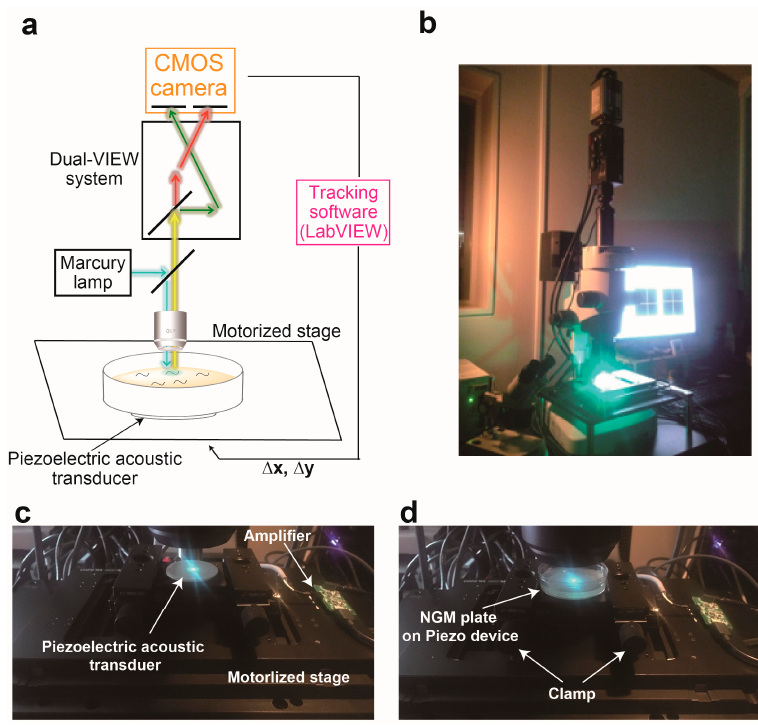
Figure 1. A system integrating piezoelectric device into calcium imaging system ( a ) Schematic diagram of the experimental set-up for the calcium imaging system combined with piezoelectric device. ( b ) The photograph of a new system. ( c , d ) The close-up photo of a piezoelectric device attached on the motorized stage ( c ) and an NGM plate on the actuator ( d ).